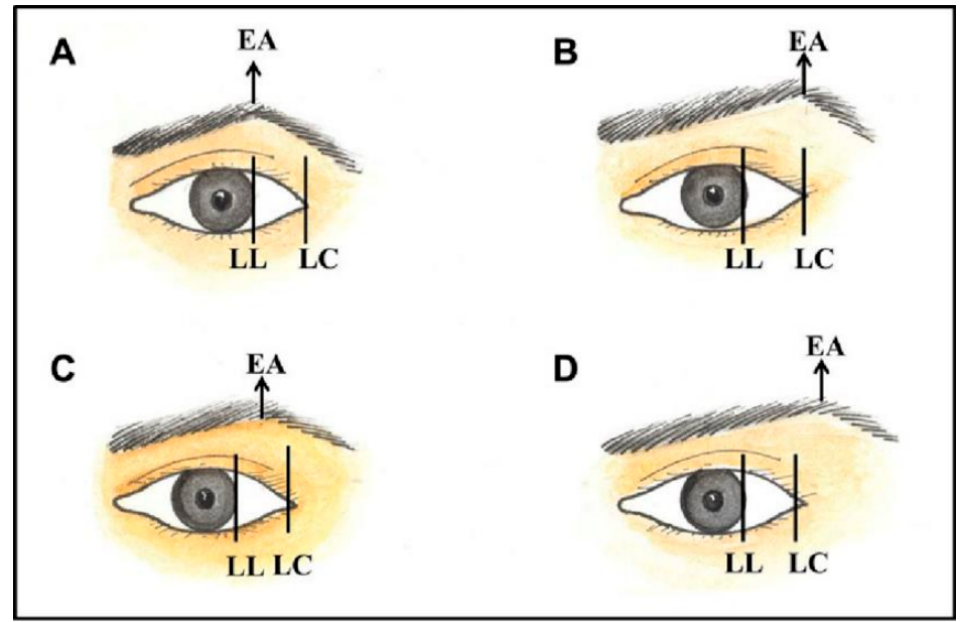
Figure 1. Different eyebrow apex positions: ( A ) above the lateral limbus, ( B ) halfway between the lateral limbus and lateral canthus, ( C ) above the lateral canthus, and ( D ) later almost brow. EA, the apex of the eyebrow; LC, lateral canthus; LL, lateral limbus [22].